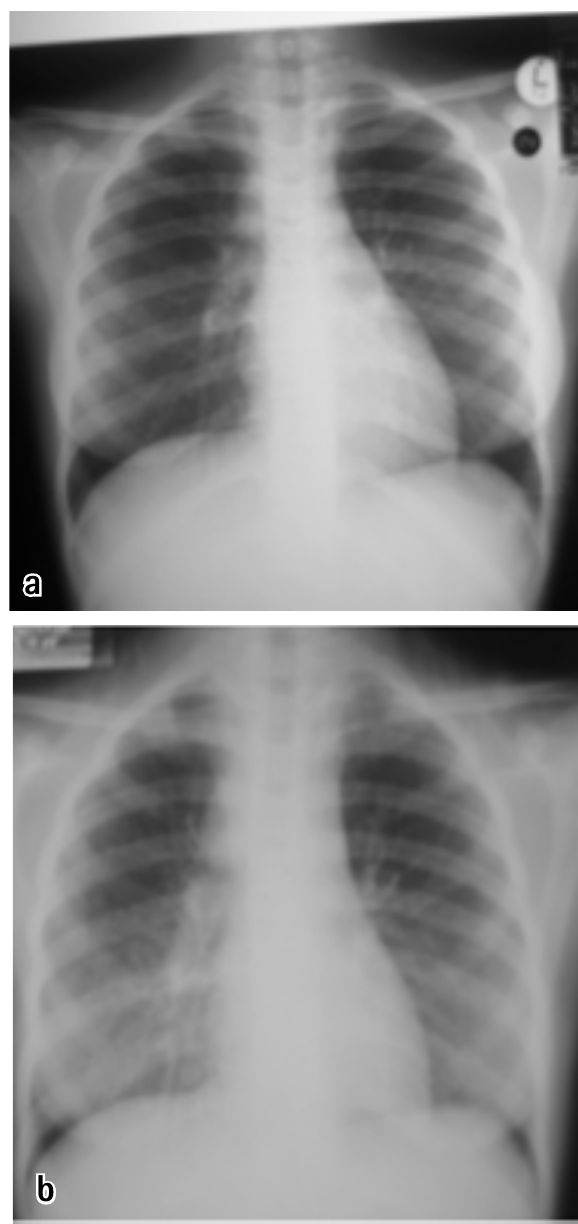
Fig. 1. Drug-resistant TB presenting as paradoxical IRIS in a 12-year-old girl with pulmonary and abdominal TB and severe immune suppression (chest radiograph a). She was sputum smear positive and had a CD4 count of 31 cells/µl. Anti-TB therapy with four drugs was initiated and she responded well, smear conversion taking place within 3 weeks. ART was started 3 weeks after initiation of TB therapy, and 7 days later she developed a high fever, severe abdominal pain and food intolerance. The sputum smear was now positive, and a chest radiograph (b) suggested miliary TB. Steroids were added with some clinical improvement. Rifampicin resistance was confirmed after 48 days on TB therapy and 27 days on